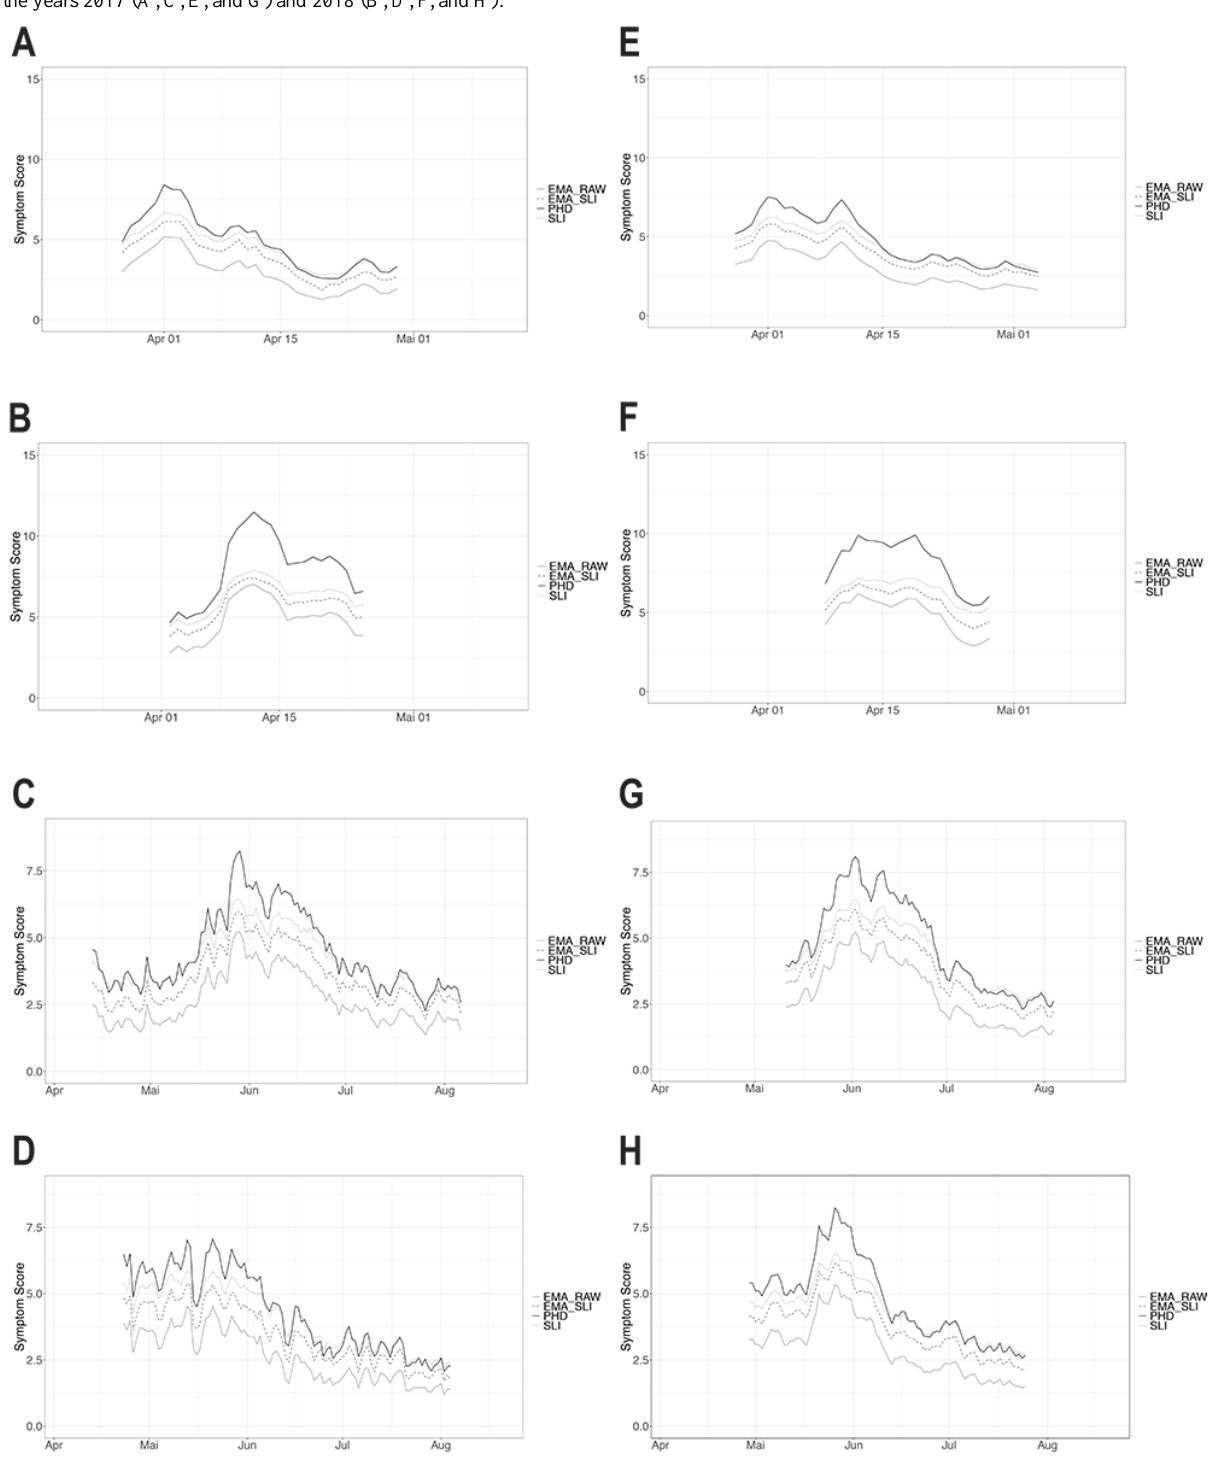
Figure 1. Pattern of the four calculation methods: dark continuous line=raw Patient’s Hayfever Diary score (PHD), gray dots=symptom load index of the raw Patient’s Hayfever Diary score (SLI), gray continuous line=European Medicines Agency raw score (EMA_RAW), gray dashed line=symptom load index of the EMA score (EMA_SLI) for the Austria (A-D) and Germany (E-H) for the birch (A-B and E-F) and grass (C-D and G-H) pollen seasons for the years 2017 (A, C, E, and G) and 2018 (B, D, F, and